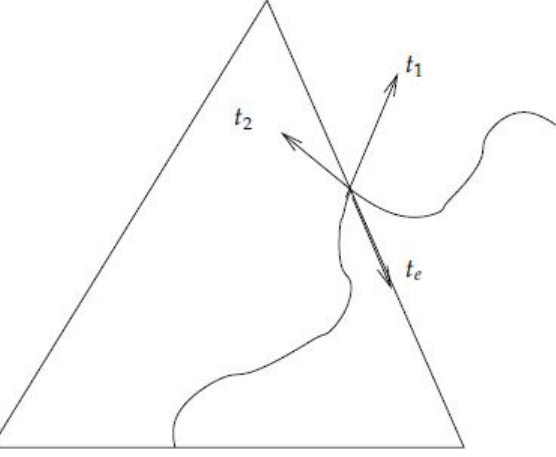
Figure 3. Curvature at intersection with the